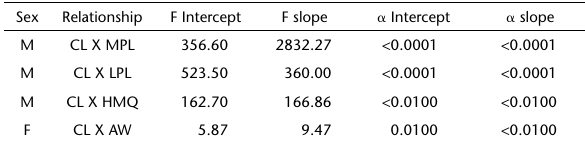
Table 2. Summary of comparisons between the straight lines of Aegla georginae juveniles and adults in the Perau Creek, Ibicuí Basin, Brazil. (M) Male, (F) female, (CL) cephalothorax length, (AW) second abdominal somite width, (MPL) minor propodus length, (LPL) larger propodus length, (HMQ) height of major